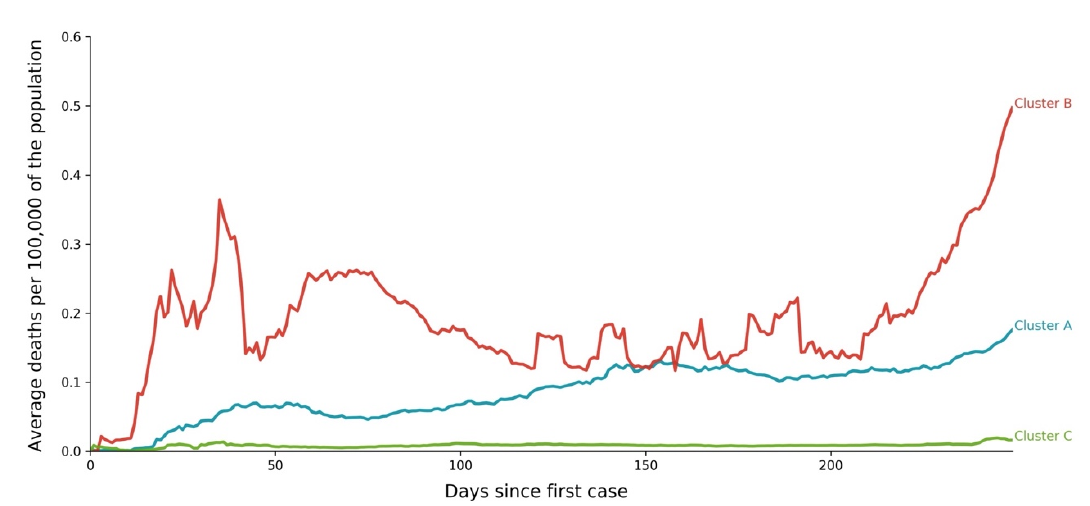
Figure 10. Seven-day moving average of deaths per 100,000 people and in each cluster over time.